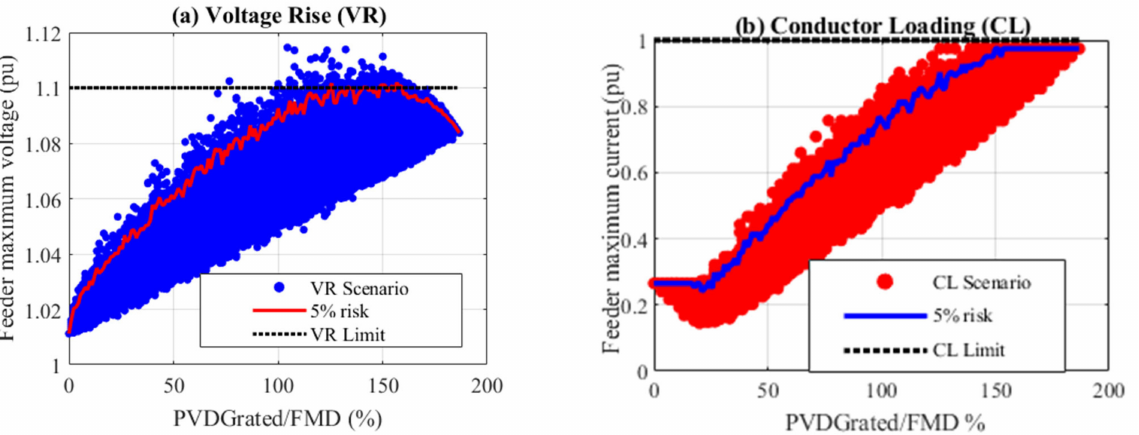
Figure 9. Illustration of the response of the resized feeder. ( a ) Voltage rise ( b ) conductor